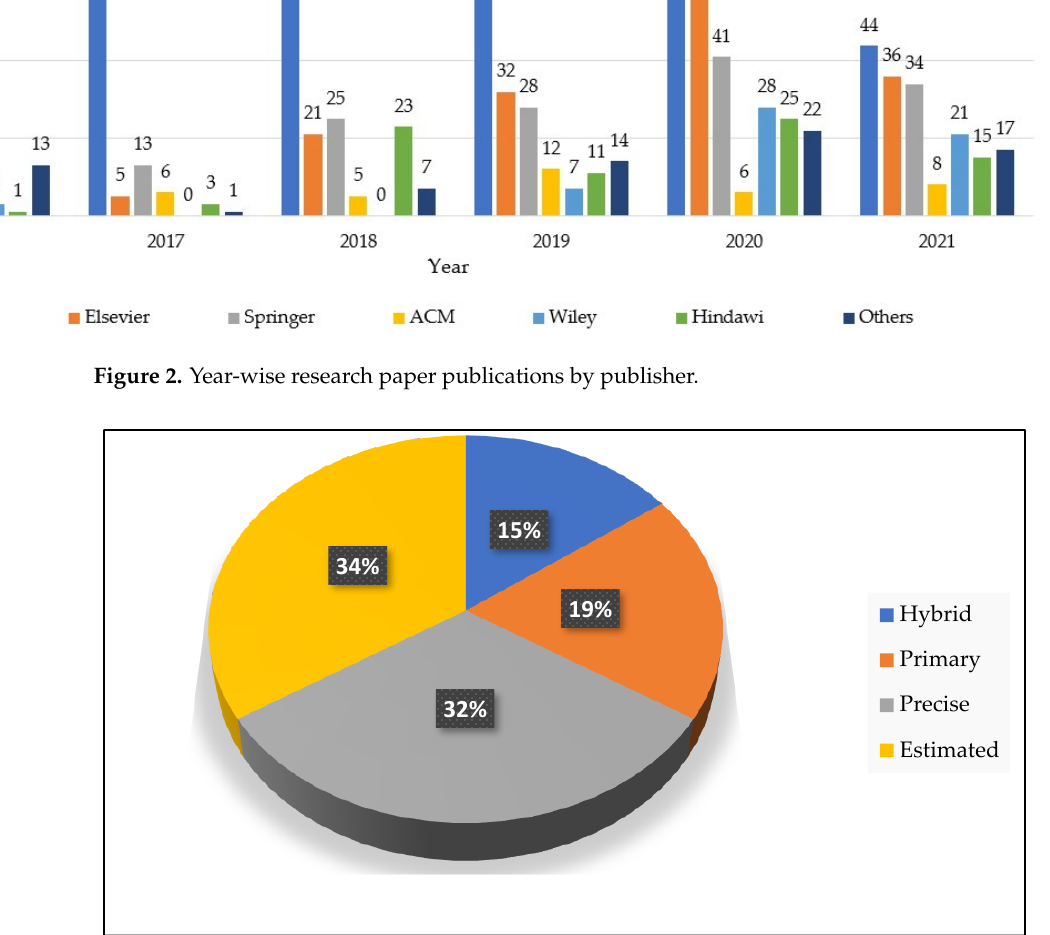
Figure 3. Percentage-wise load-balancing techniques used in fog computing .